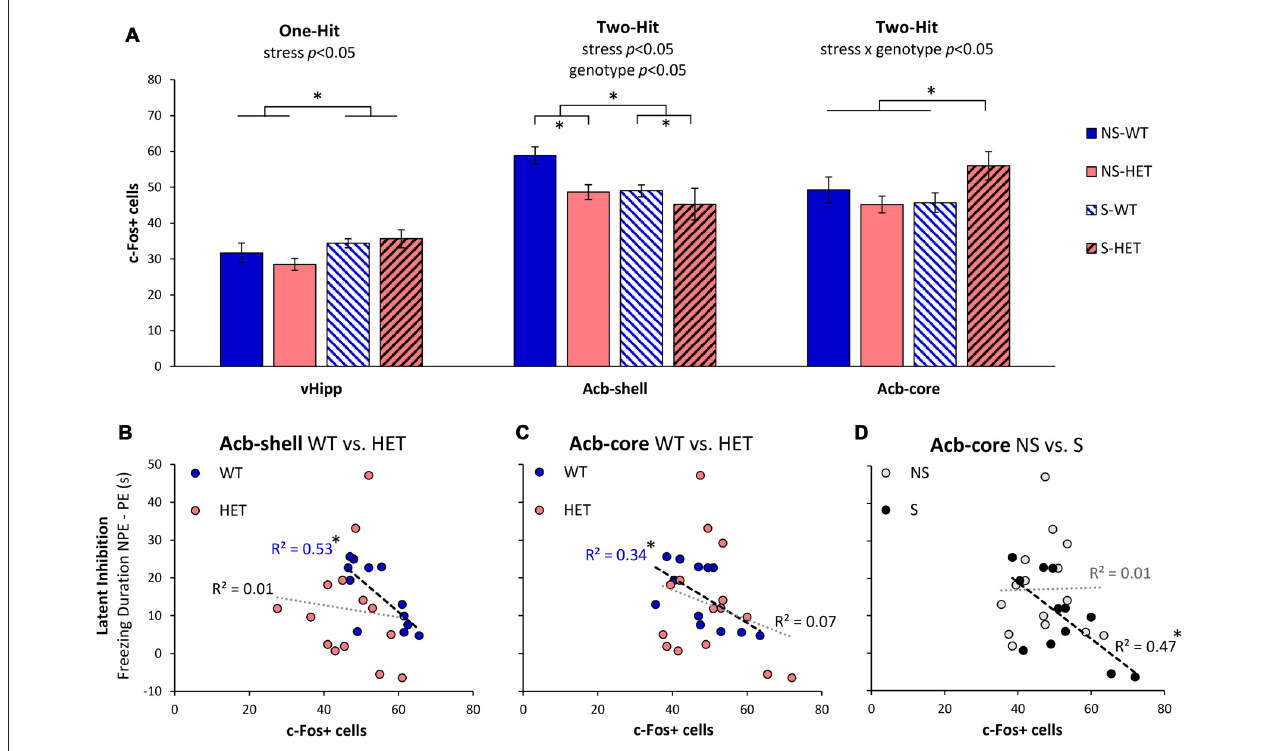
FIGURE 2 | Neuronal activation during LI testing. (A) Average c-Fos+ cell counts ( ± SEM) in ventral hippocampus (vHipp), nucleus accumbens shell (Acb-shell), and nucleus accumbens core (Acb-core) in the stress (S) and no-stress (NS) GDNF-deficient mice (HET) and WT littermate controls. Analyses indicated different patterns of effects of stress and genotype on neuronal activation in these brain regions: vHipp activation was affected only by stress (one-hit), Acb-shell activation was independently affected by stress and genotype (independent two-hit), while Acb-core activation was affected by the interaction stress × genotype (two-hit interaction). (B–D) Correlations between LI (difference in freezing duration to the NPE, and PE, stimuli) and neuronal activation (number of c-Fos+ cells) in Acb-shell (B) and Acb-core (C,D) when data are collapsed across stress (B,C) or genotype (D) . ∗ p <